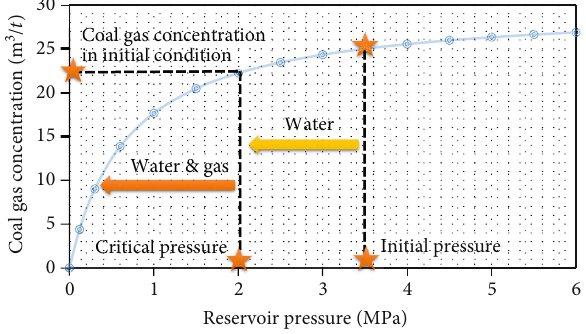
Figure 2: Gas content change during coalbed methane